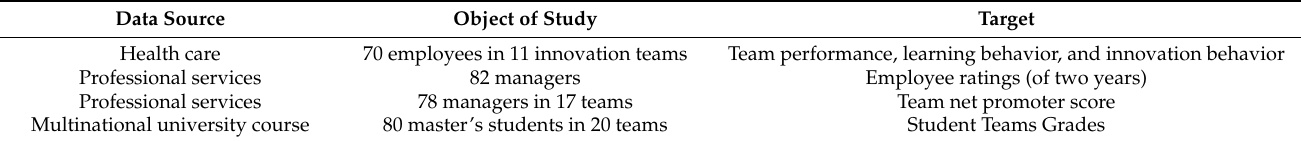
Table 3. Data Sources for each